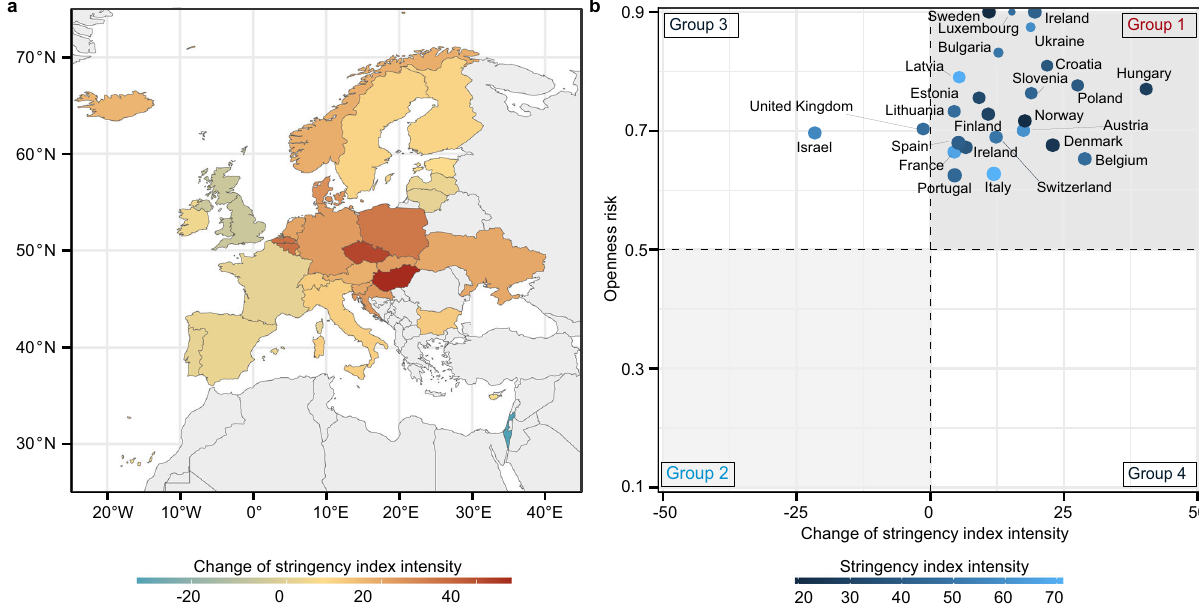
Fig. 4 The possible relaxation of NPIs or the requirement of extra stringency to contain COVID-19 across countries. a Under the scenario of vaccination and COVID-19 transmission by 25 October 2021, required changes of NPI stringency index to contain COVID-19 ( R t < 1). The negative change means the degree of NPI relaxation, compared to the stringency on 25 October 2021. b The comparison between the estimated requirement of changes in NPI stringency index presented in ( a ) and the output of the openness risk (from 0 to 1) - an indicator modi fi ed from the OxCGRT ’ s approach 25 . A higher openness risk ( > 0.5) means an increasing likelihood of COVID-19 resurgence, and vice versa. Countries in Group 1 (increasing NPI stringency) and Group 2 (relaxing NPIs) mean that they have consistent fi ndings between two indicators. Groups 3 and 4 mean that the two indicators have con fl icting results and extra evidence might be